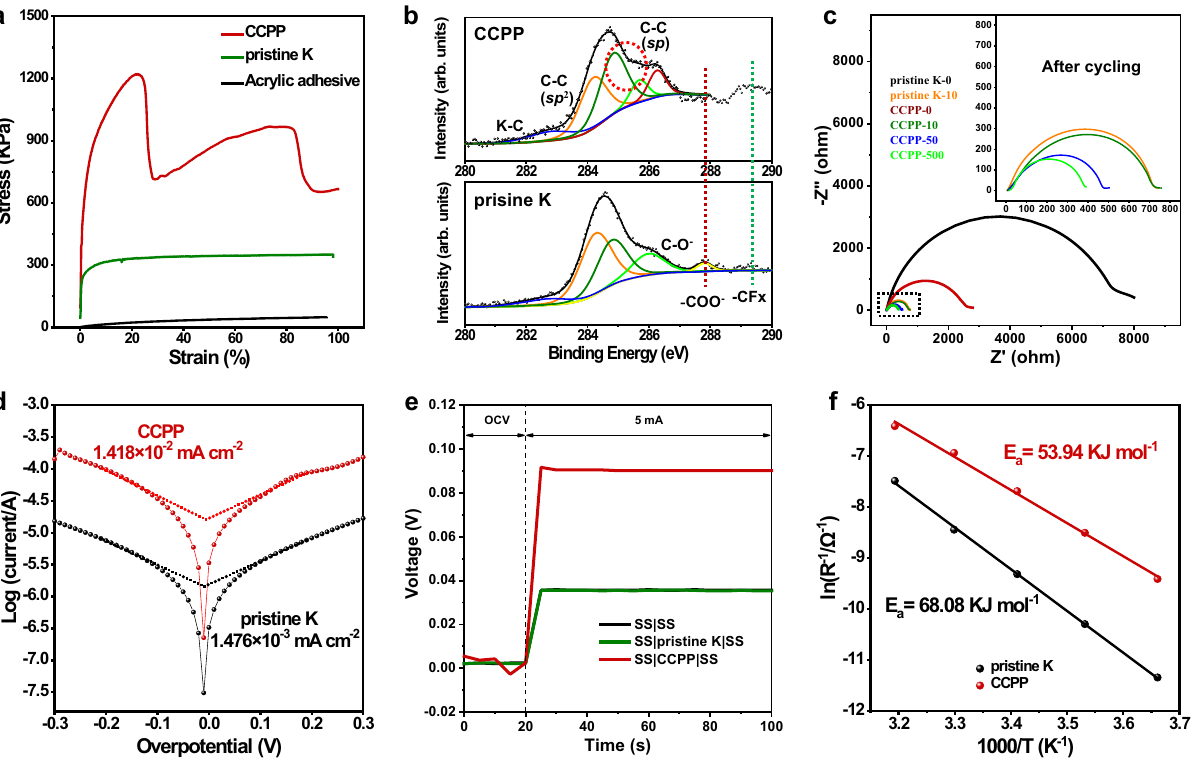
Fig. 3 Mechanical, interfacial and ion-transport properties of CCPP. a Stress – strain curves of CCPP, pristine K, and acrylic adhesive. b C 1 s XPS spectra of CCPP and pristine K after 20-h cycling. c Nyquist plots taken at various cycle numbers. d Tafel plots and derived exchange current density obtained from linear sweep voltammetry tests in the range of − 0.3 V to 0.3 V at 2 mV s − 1 . e D.c. conductivity Measurements of pristine K and CCPP using blocking electrodes. f Corresponding Arrhenius curves and comparison of activation energies of CCPP and pristine K. Source data are provided as a Source Data fi